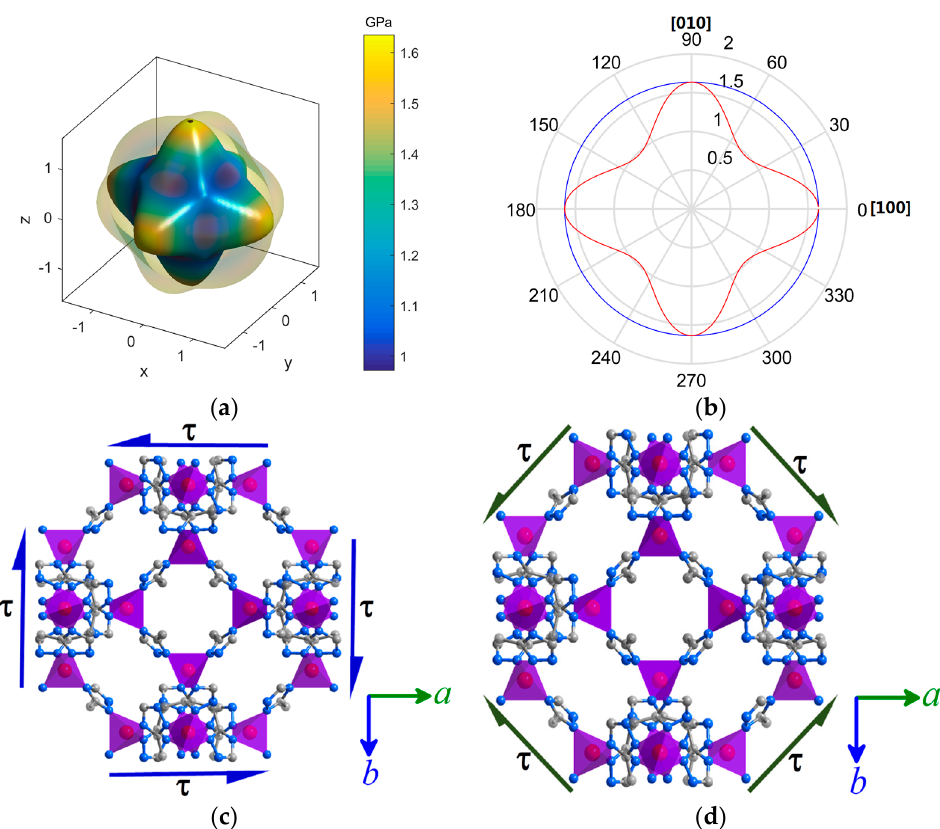
Figure 4. Shear modulus ( G ) representation surfaces. ( a ) 3D and ( b ) 2D surface based on the calculated elastic constants, The opposing shear stresses τ are applied ( c ) on the (100) planes along <0kl> directions and ( d ) on the (110) planes along <110> directions, corresponding to the maximum and minimum shear modulus.